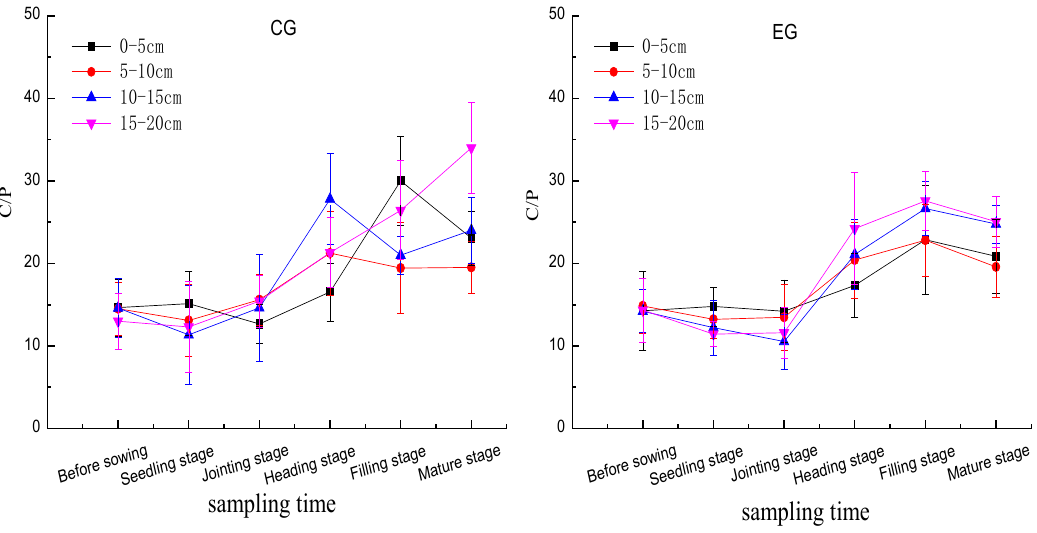
Figure 5: Temporal variation of C/P ratio in the control group (CG) and the experimental group (EG) soils subject to poultry wastewater